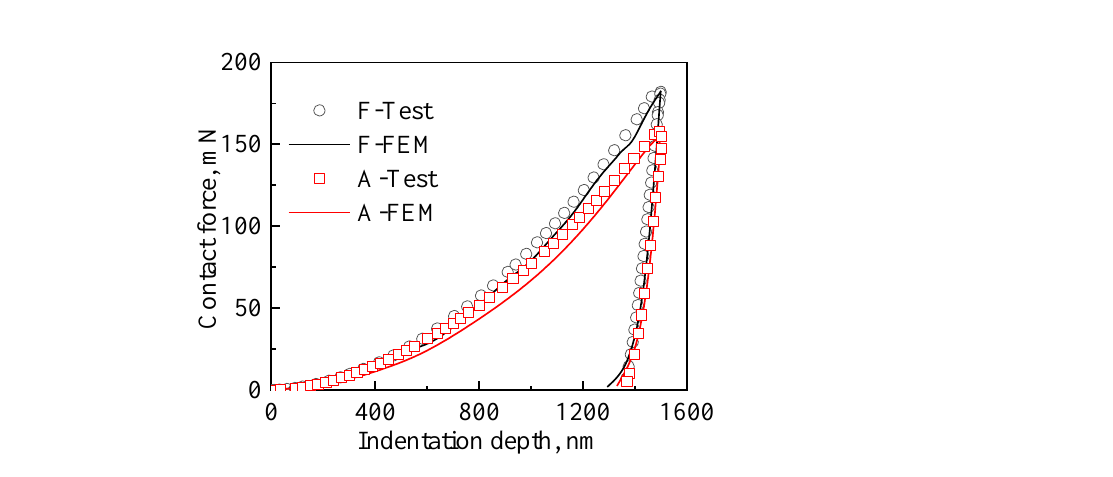
Figure 10. Load–pressing depth curve for nanoindentation experiments and finite element simulation